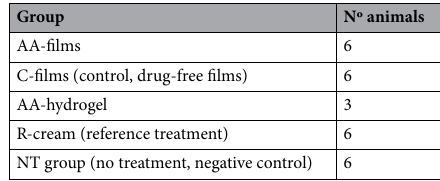
Table 2. Assignment of experimental